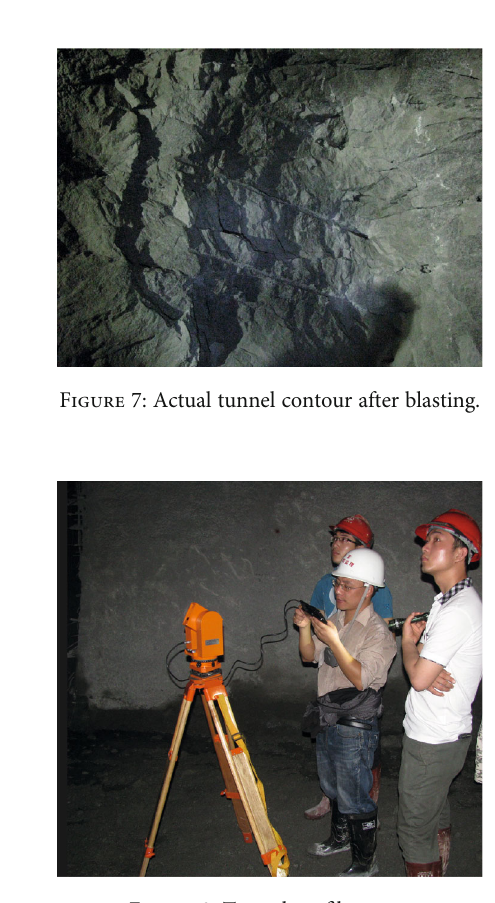
Figure 6: Layout diagram of the blasting holes.